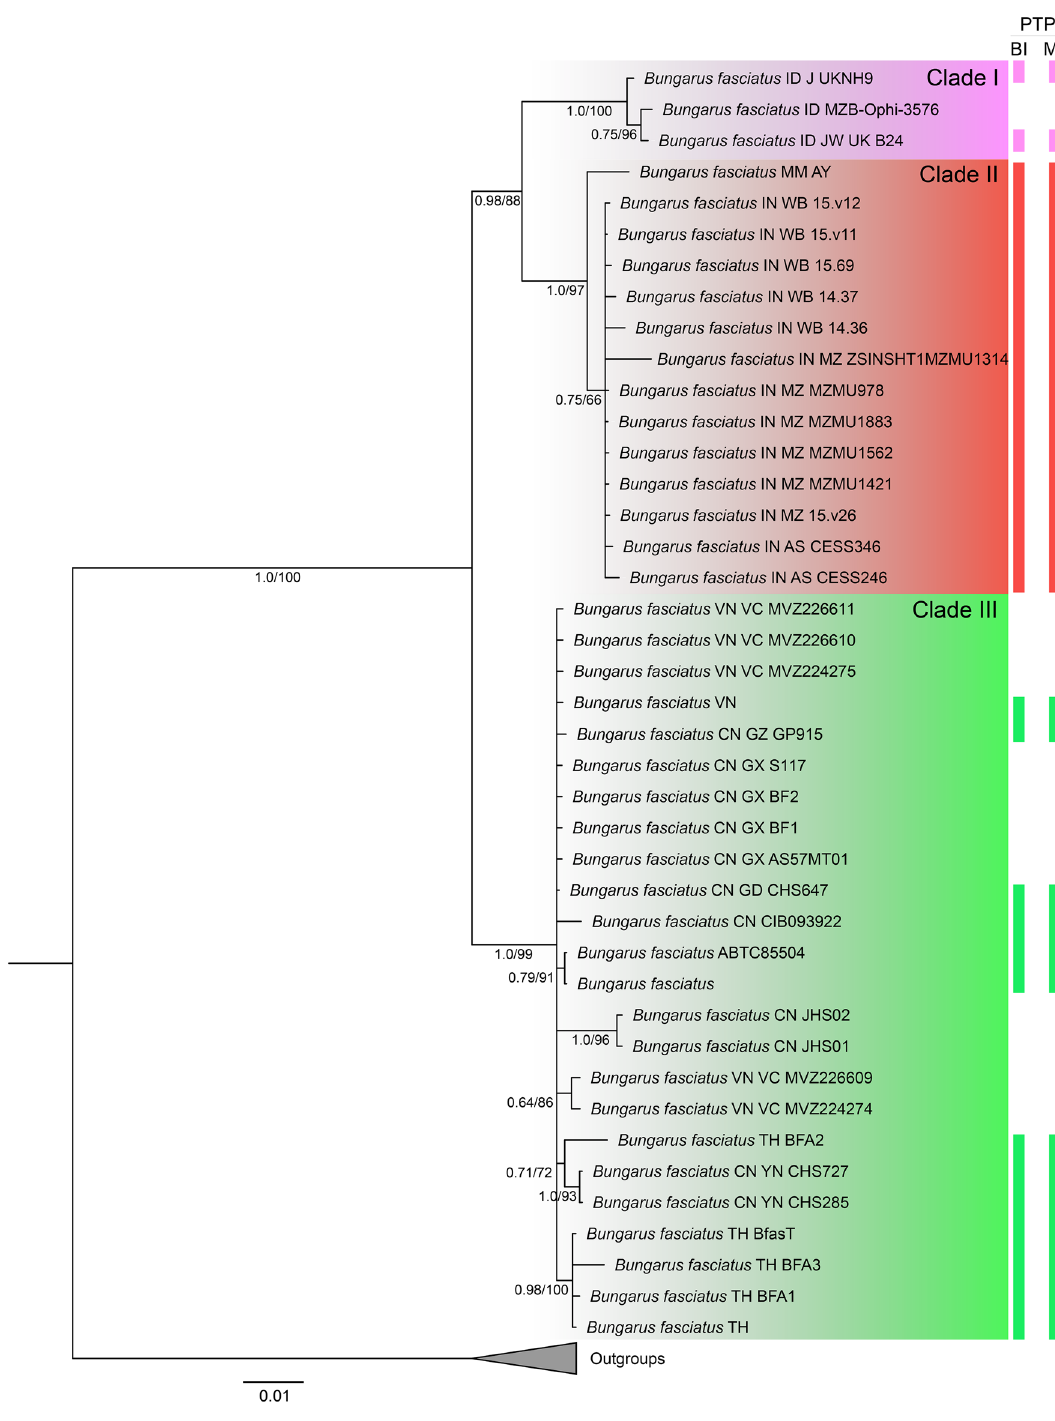
Figure 1. Bayesian inference (BI) phylogenetic tree based on concatenated mitochondrial 16S, COI, ND4 and CYTB genes; lineage partitions recovered from CYTB-based PTP analyses are presented besides the BI tree (only the CYTB dataset was utilized for PTP analyses because it contains more representative samples from the three clades compared to the other genes). Values at each node represent Bayesian posterior probabilities (PP) and Ultrafast Bootstrap (UFB) values from the Maximum Likelihood (ML) analysis (PP/UFB). Abbreviations of country and state/province names are: ID Indonesia, JW/J Java, MM Myanmar, AY Ayeyarwady, IN India,